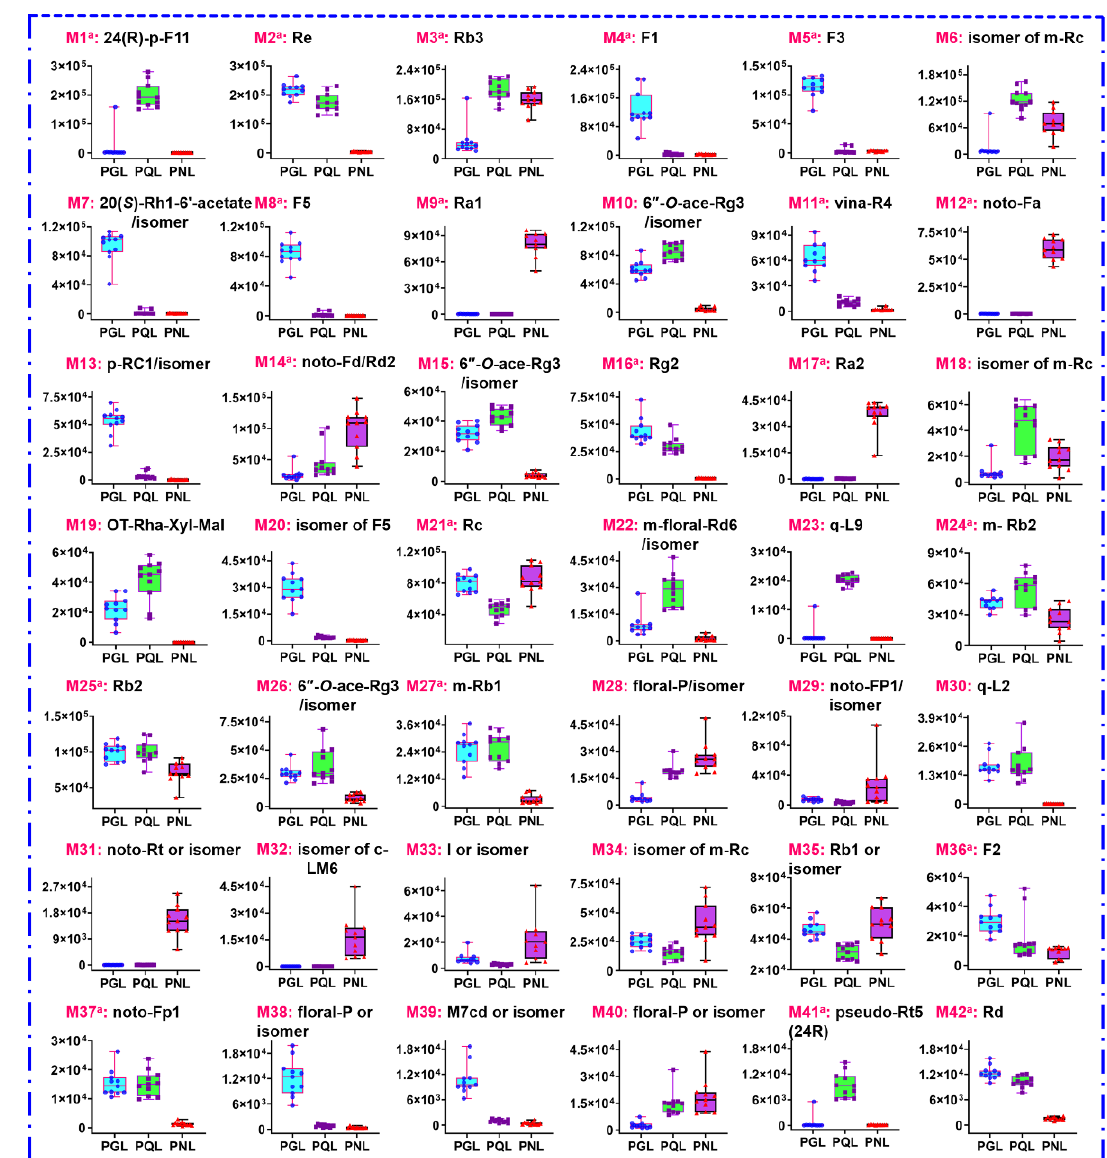
Figure 8. Box charts illustrating the content difference of 42 important ginsenoside markers among PGL, PQL, and PNL. (c-: chikusetsusaponin; q-: quinquenoside; noto-: notoginsenoside; floral-: floralginsenoside; p-: pesudoginsenoside; vina-: vinaginsenoside; m-: malonylginsenoside; ace-: acetyl; m-floral-: malonylfloral).